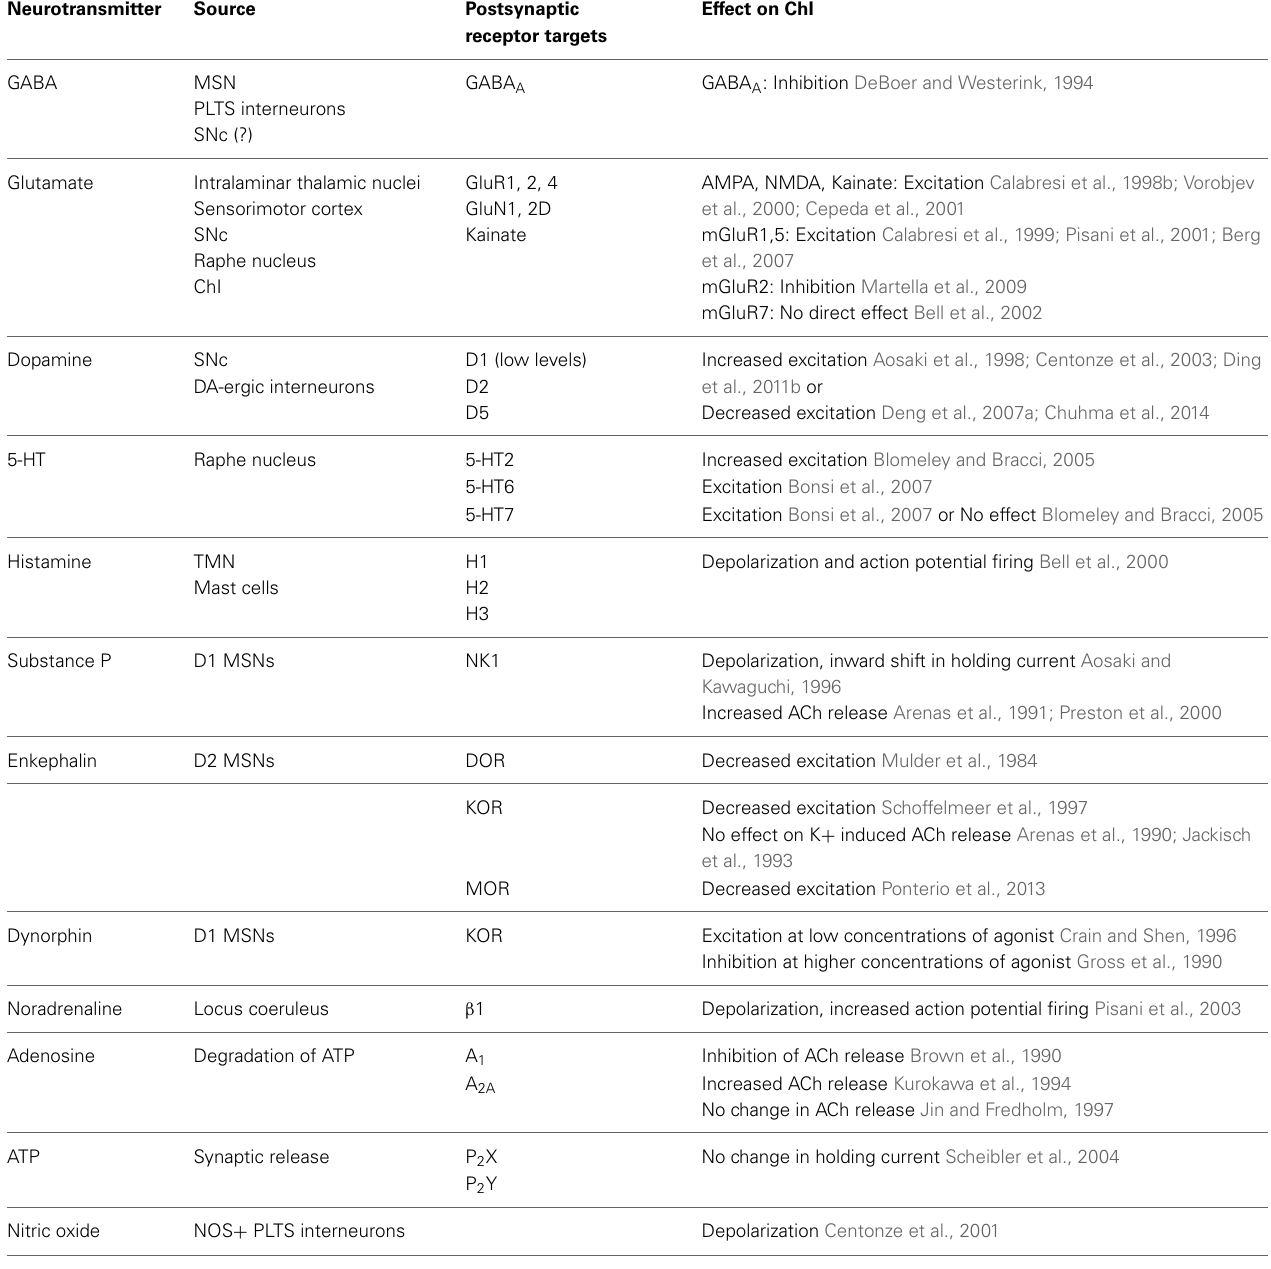
Table 2 | Neurotransmitter systems and their effects on ChI activity.